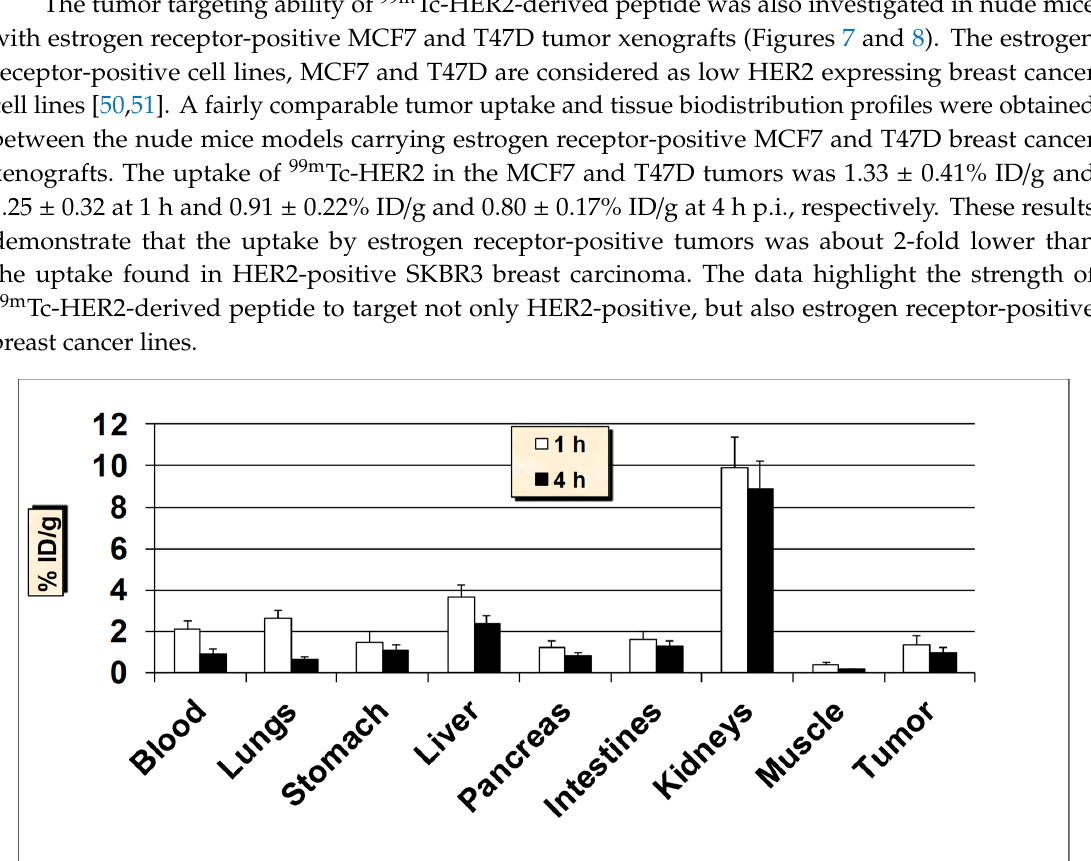
Figure 7. In vivo tumor-targeting properties of 99m Tc-HER2 peptide in ER-positive MCF7 breast cancer xenografts mice models. Data is represented as % injected dose per gram (% ID/g) of tissue/organ (n = 3 − 5, mean values ± SD). Part of the intestines was measured without their contents.